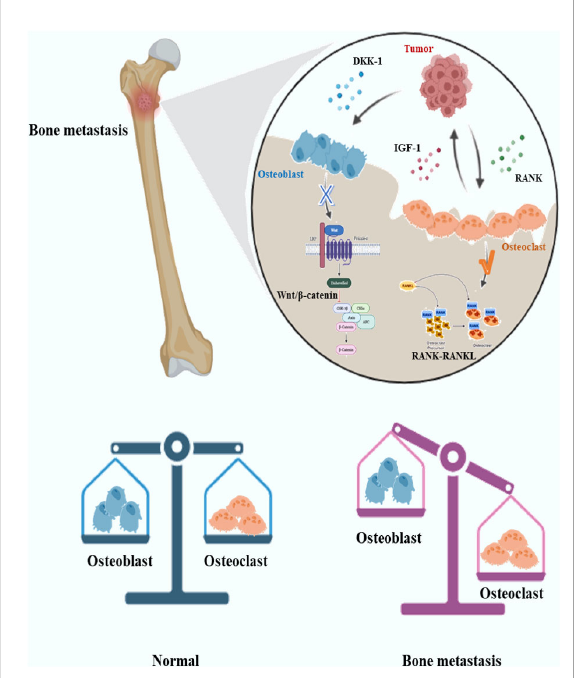
FIGURE 2 Schematic diagram of the interaction between tumor cells and osteoblasts/osteoclasts in osteolytic bone metastases. In osteolytic lesions, tumor cells may secrete molecules such as DKK-1 to inhibit osteoblast Wnt signaling pathway and promote osteoclast function through RANK-RANKL signaling pathway. Osteoclasts may secrete IGF-1 and other molecules to promote tumor growth.DKK-1, Dickkopf-1; IFG-1, Insulin-like growth factor 1; RANK, Receptor Activator of NF- k